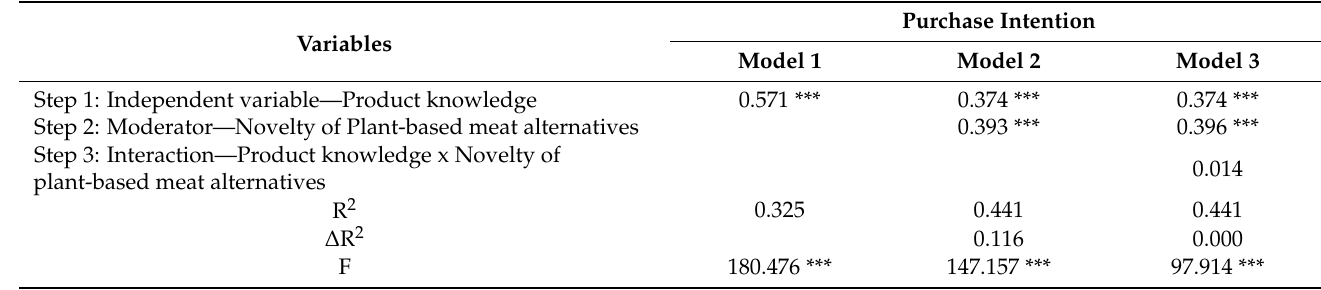
Table 6. Results of hierarchical regression